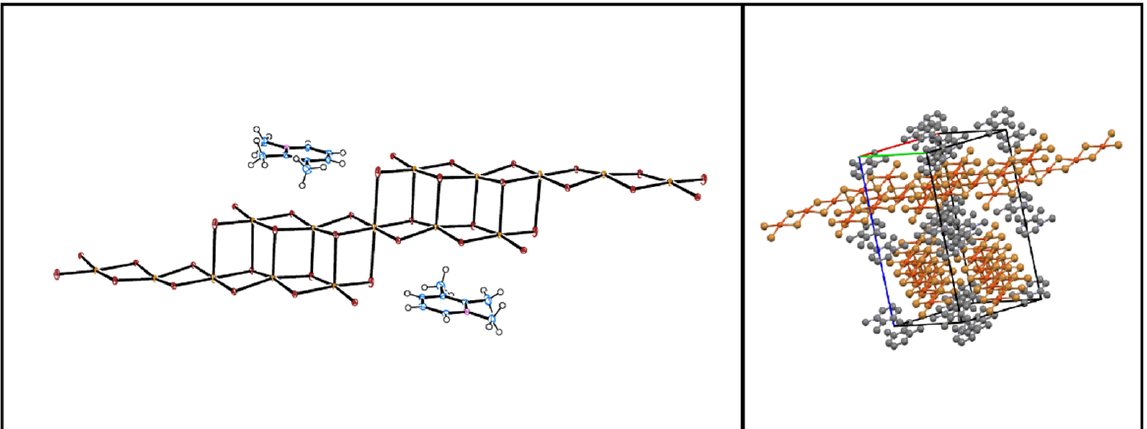
Figure 9. Diptych depicting the ORTEP diagram (50% ellipsoids) for the hypothetical structure obtained by . . . AAAA . . . stacking of mixed organic cation/oligomer sheets (left) and the unit cell packing diagram (right) viewed along (110) (in the transformed unit cell) down one oligomer stack ori- entation with the other stack orientation along (1 1(cid:3364) 0). The stacks are arranged into layers along (002) separated by organic cation pairs.